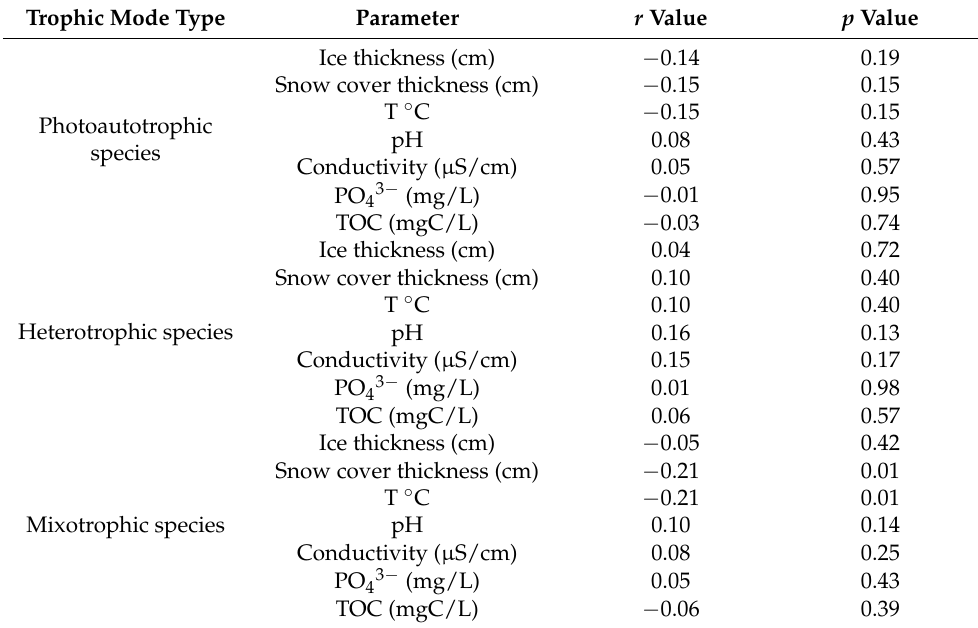
Table 3. Results of correlation analysis (Kendall correlation coefficient) to assess the relationship between species abundance of different groups and physicochemical parameters of the environment (see Table